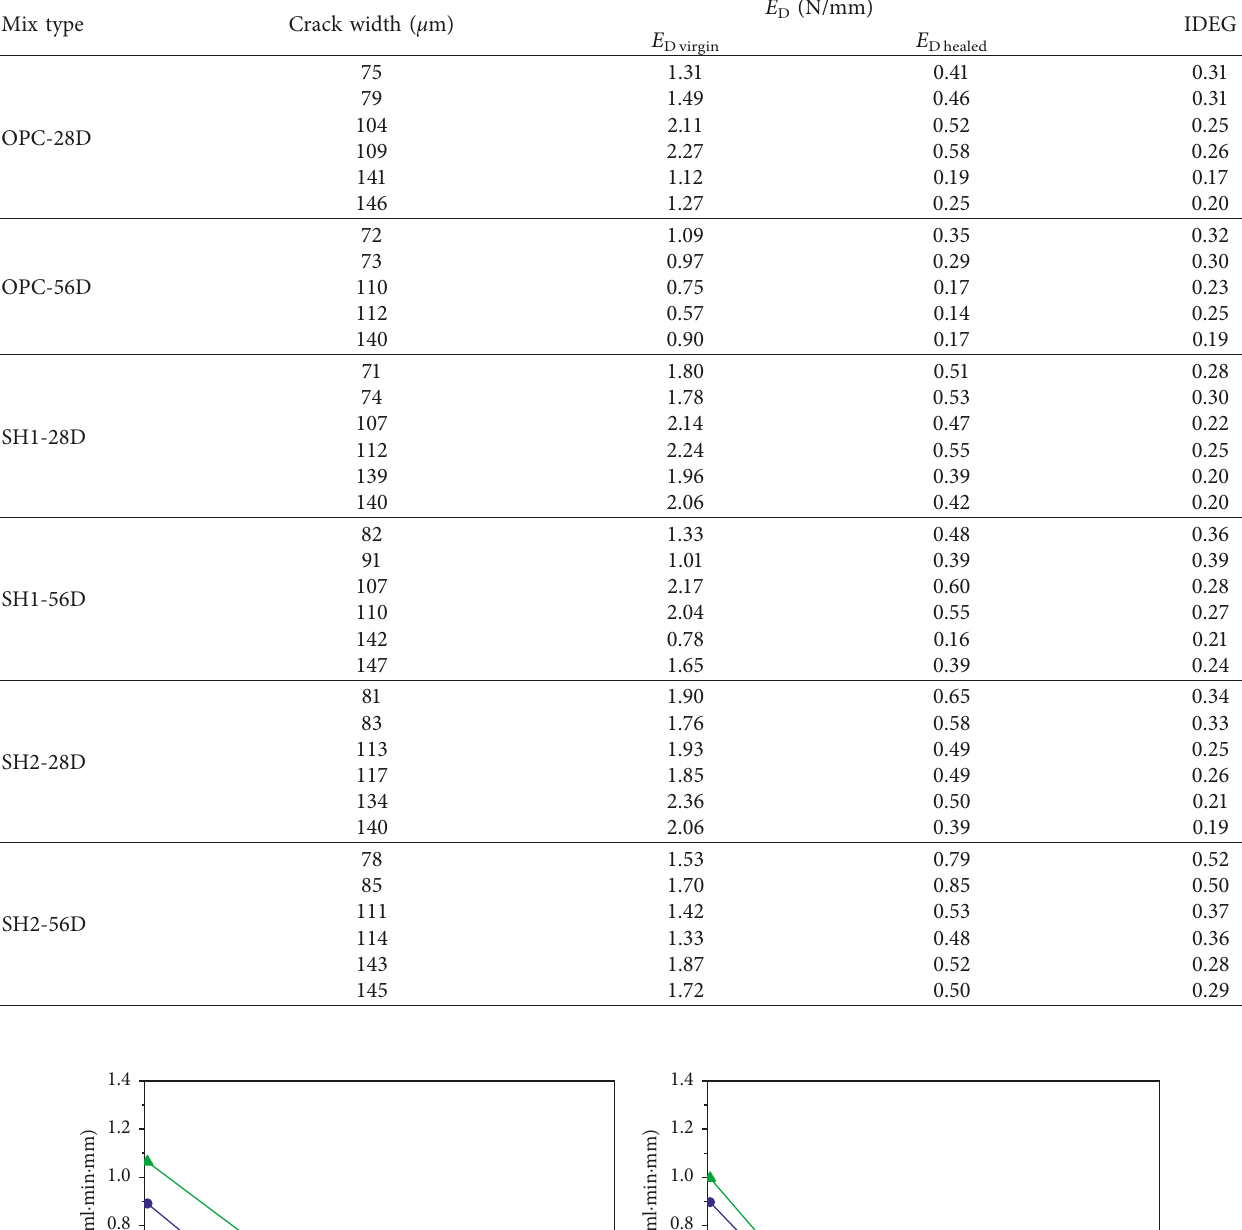
Table 4: Calculated dissipation energy gain under stress ( σ ) vs. CMOD curve, index of dissipation energy gain (IDEG) for different mix